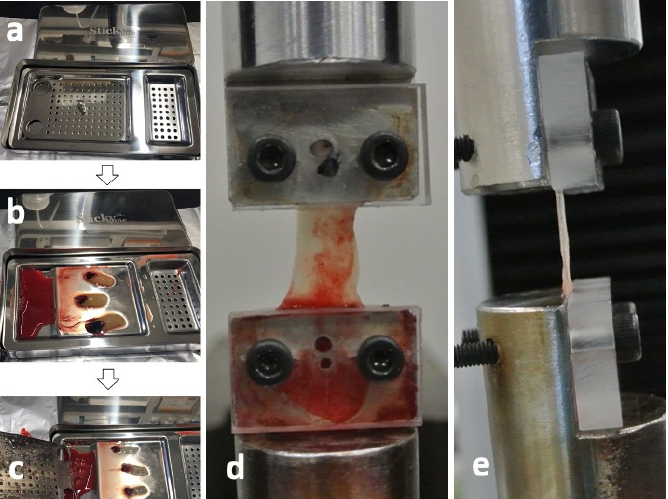
Figure 7. Test preparation of concentrated growth factor (CGF) membrane. ( a ) Stainless-steel compression device (Sticky Bone TM , Jeonju, Korea) to transform into CGF glue into membrane, ( b ) CGF glue on device before press, ( c ) CGF membrane after press, ( d ) frontal view after CGF set, ( e ) lateral view after CGF set.